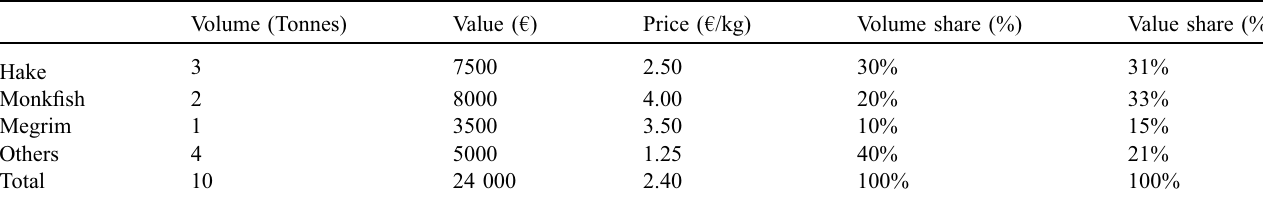
Table 3. Hypothetical example of landing composition of a fi shing